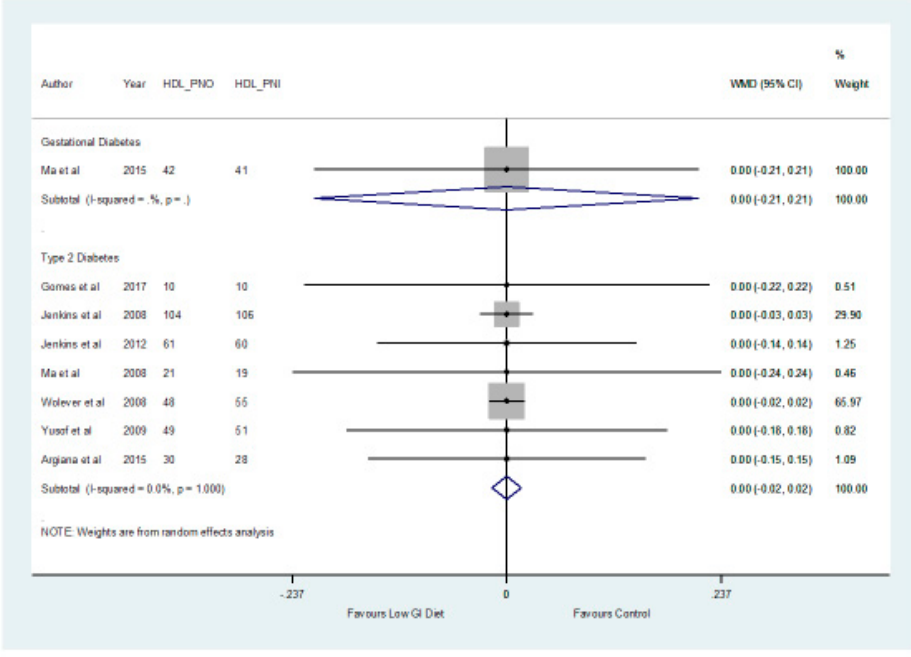
Figure 4. A forest plot showing the effects of a low GI diet on HDL cholesterol (mmol/L).